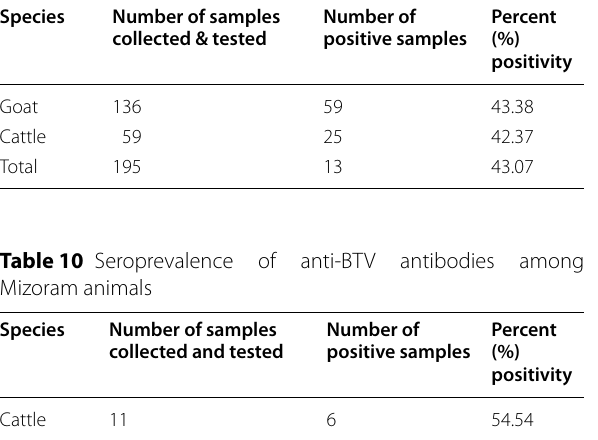
Table 9 Seroprevalence of anti-BTV antibodies among Tripura animals Species